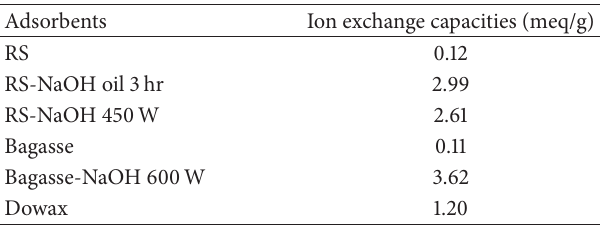
Table 4: Ion exchange capacity of each adsorbent in the sorption test.